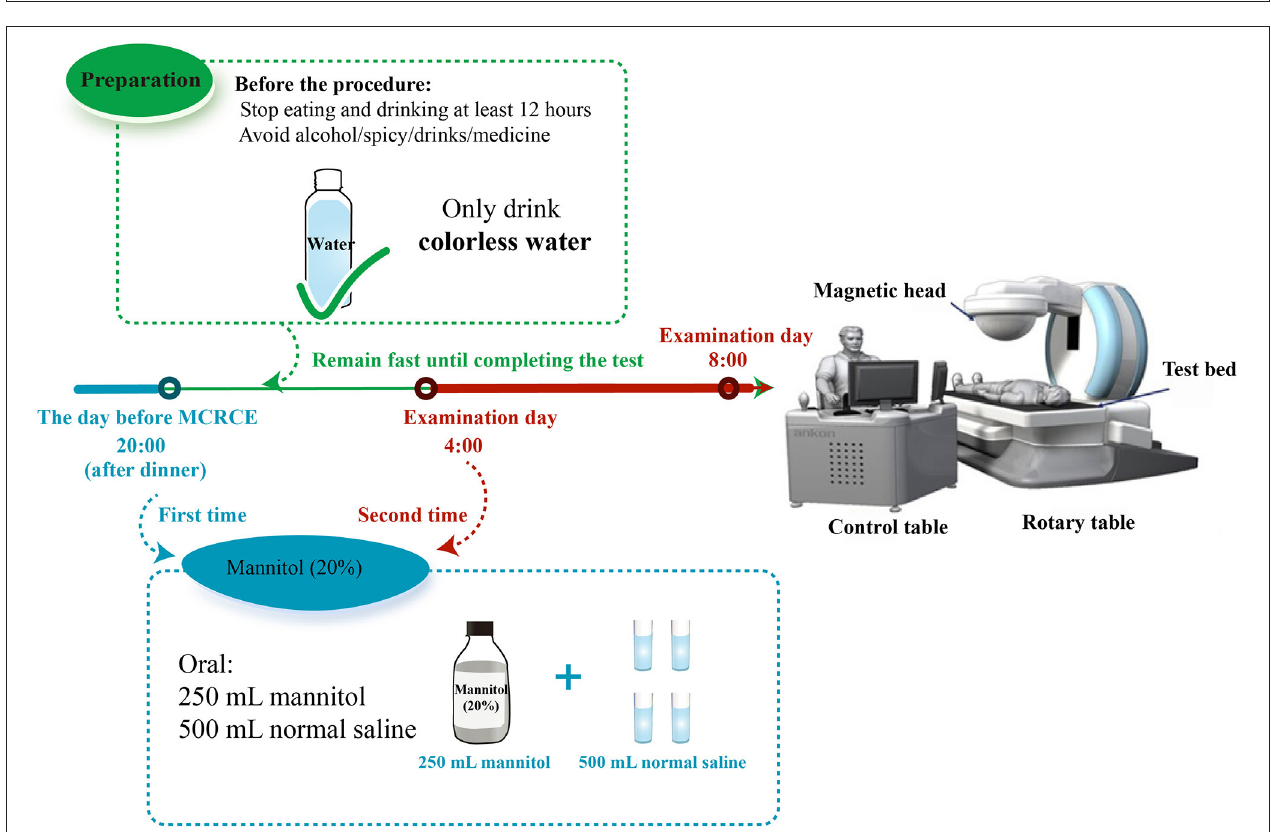
FIGURE 2 | Magnetically controlled robotic capsule endoscopy procedure.